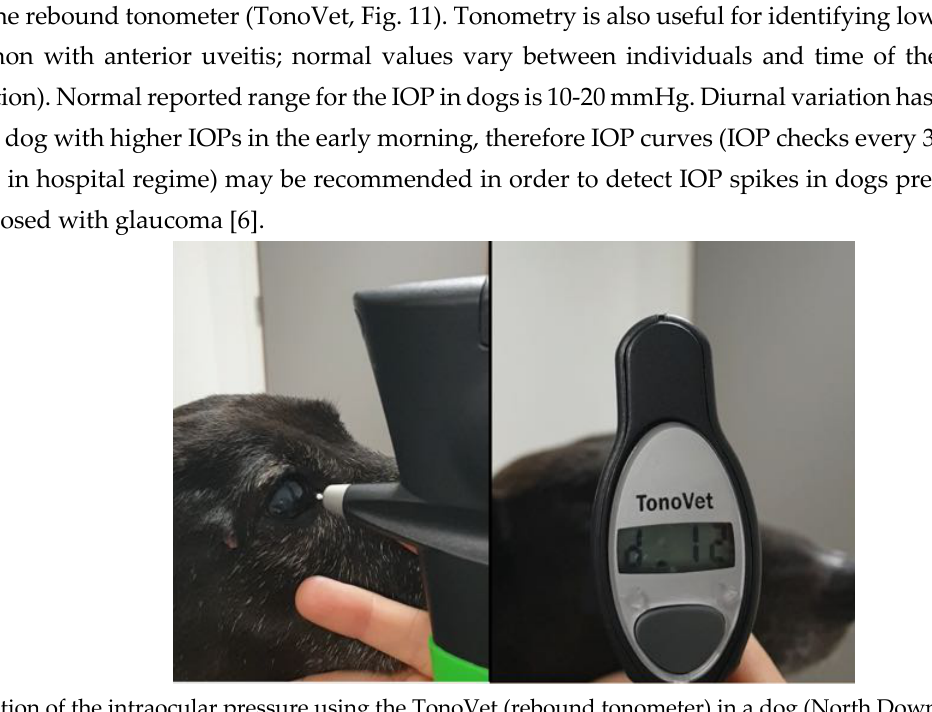
Figure 11. Estimation of the intraocular pressure using the TonoVet (rebound tonometer) in a dog (North Downs Specialist